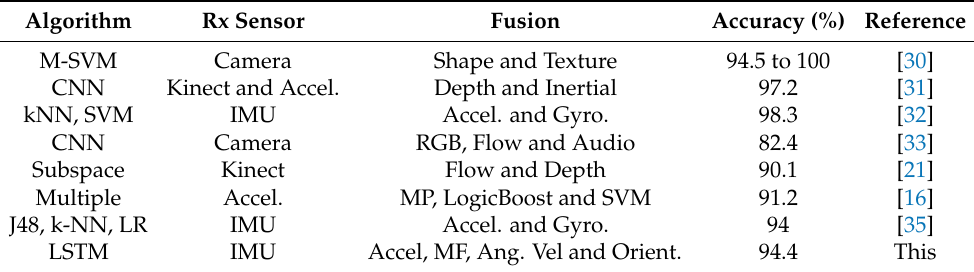
Table 1. Multi-classifier combining using machine